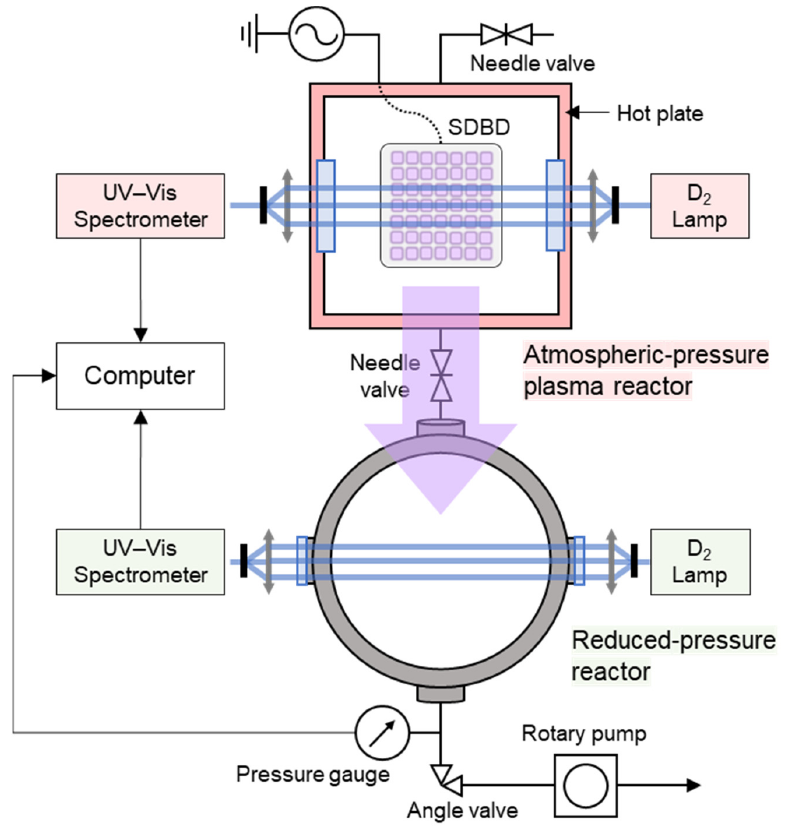
Figure 1. Schematics of the experimental setup for the direct and indirect plasma treatments. Samples were treated in an atmospheric-pressure plasma reactor or reduced-pressure reactor; the details of the processes are described in the main text. The O 3 and NO x concentrations in both reactors were determined using optical absorption spectroscopic systems.